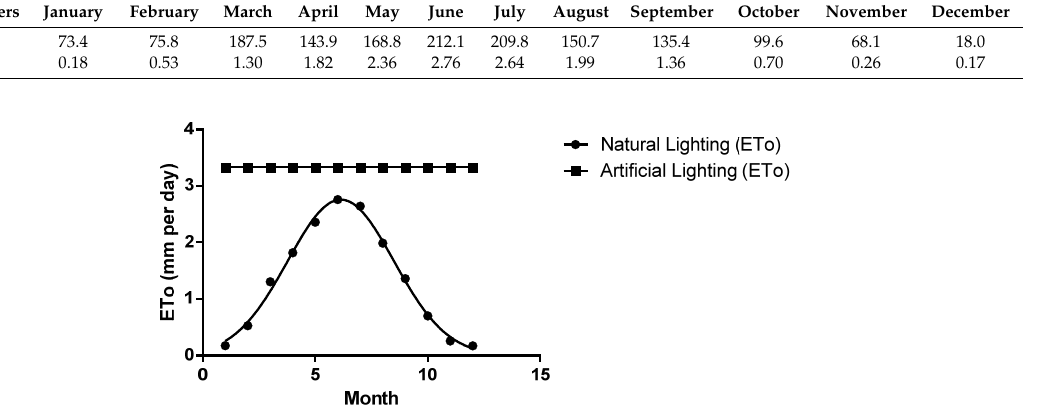
Figure 2. Reference evapotranspiration (ET o in mm/day) upon plain natural lighting (Köln ‐ Bonn) or at constant radiation using (additional) artificial light.